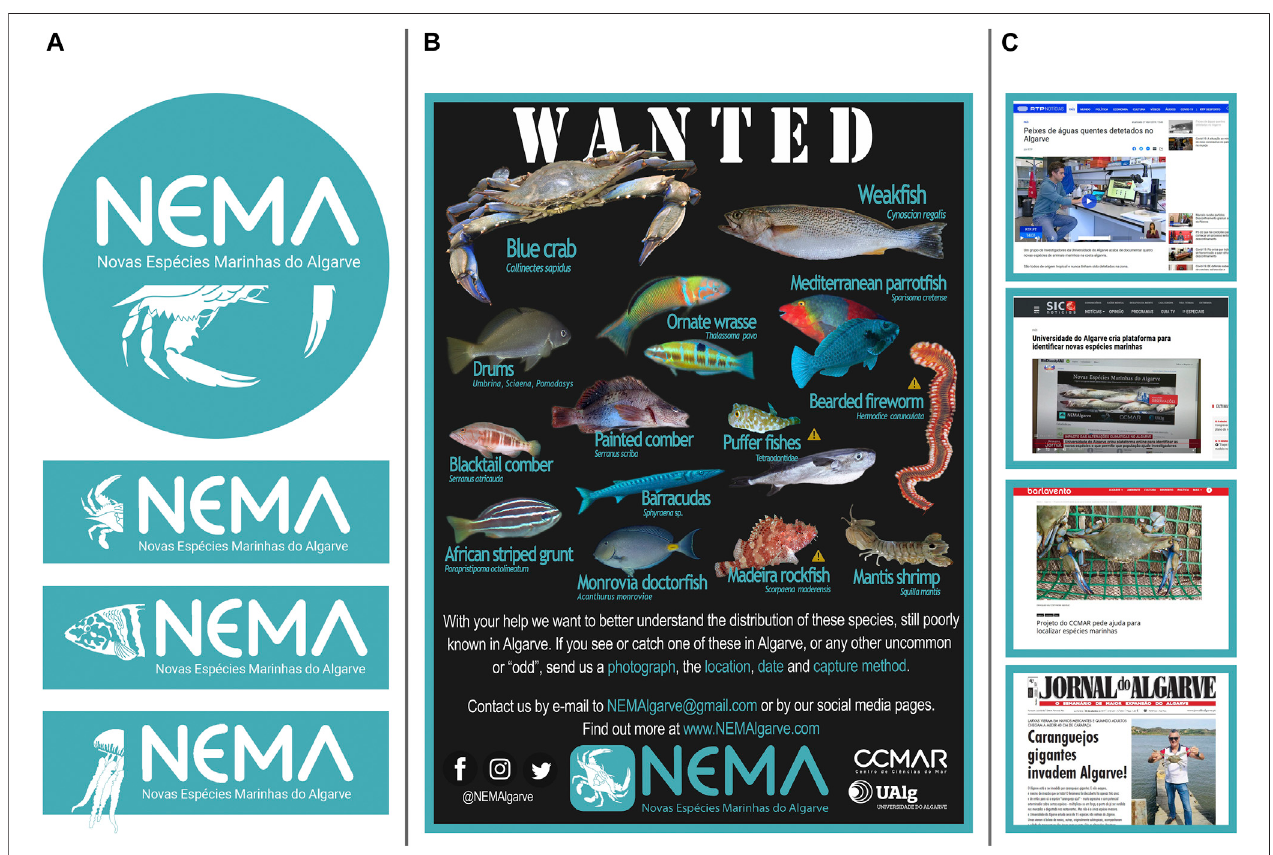
FIGURE 2 | Outreach materials and actions used to promote the NEMA citizen science campaign. (A) The NEMA institutional image includes a main logo, incorporating the Atlantic blue crab Callinectes sapidus , and complementary logos. (B) The NEMA “ WANTED ” poster used to promote the campaign on social media and call citizens for participation. (C) NEMA outreach actions resulted in tremendous media coverage, including interviews given to national television, and printed and online newspaper articles. For a complete list of media coverage, see Supplementary Table S1 of the online Supplementary Material.